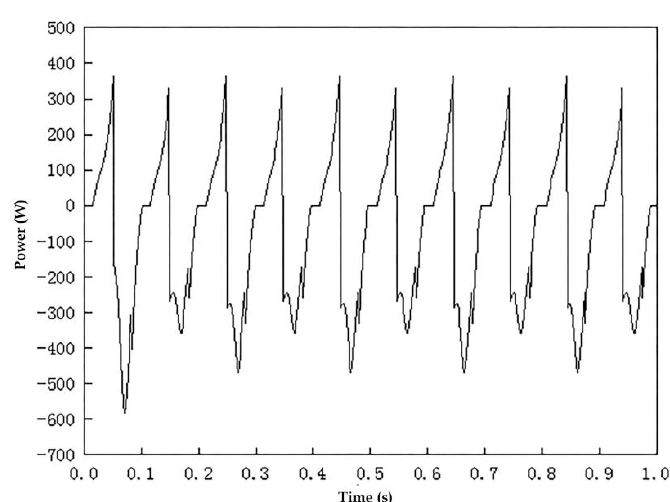
Figure 17. Excitation Power in DLSRG excitation stage.